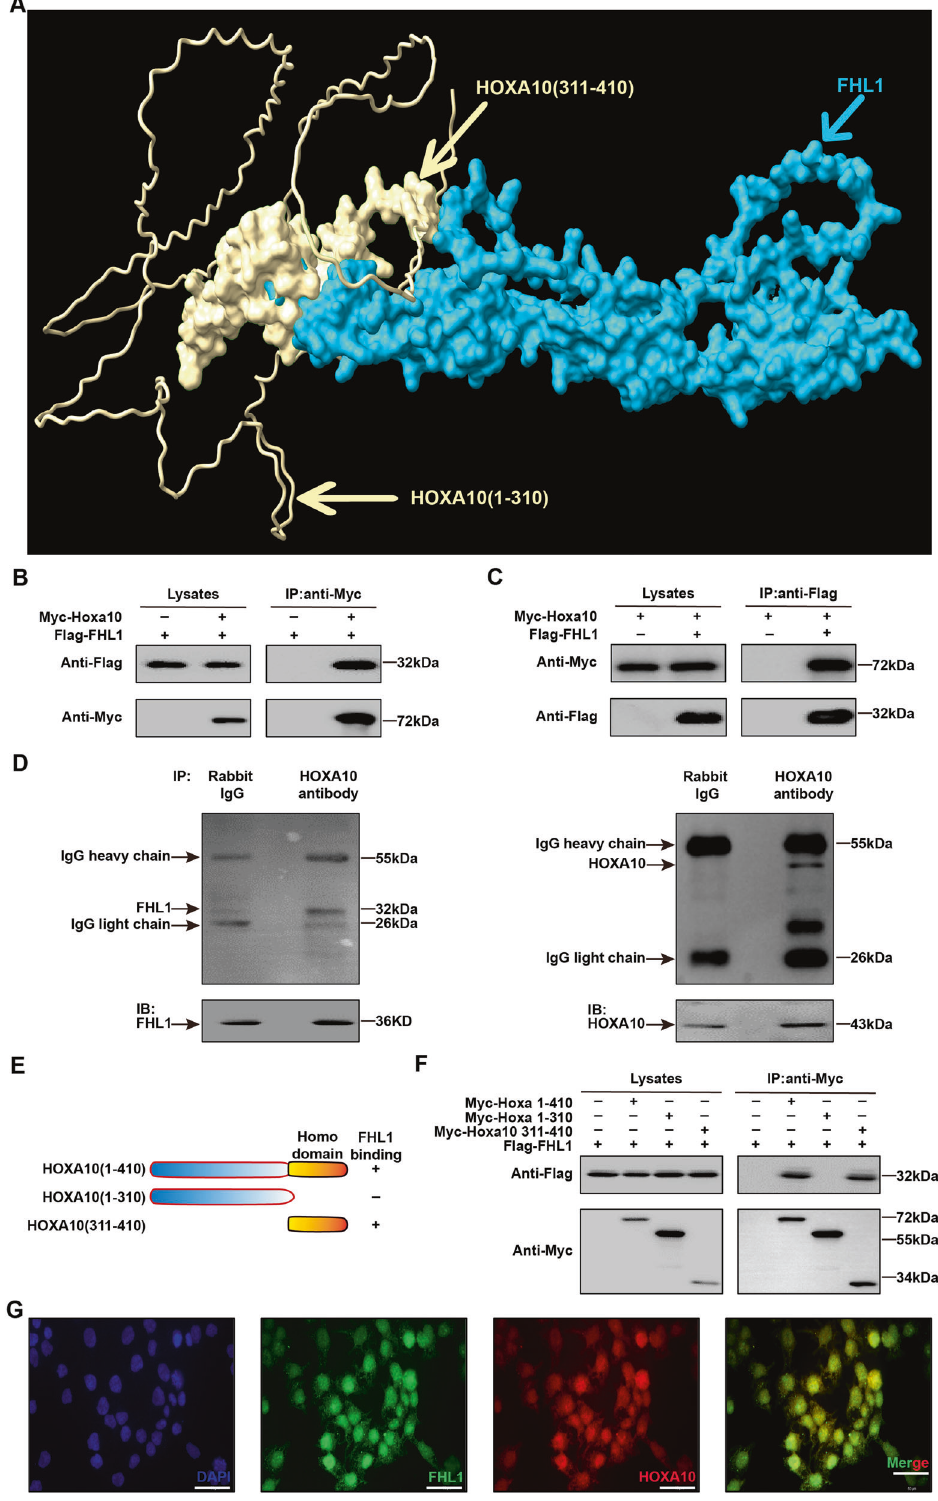
Fig. 4 FHL1 is a newly identi fi ed HOXA10-interacting molecule. A Bioinformatics-based prediction of structural interactions of FHL1 with HOXA10 protein. B , C Anti-Myc/Flag immunoprecipitation followed by immunoblotting analysis of whole-cell lysates of HEK293T cells transfected with Flag-FHL1 either alone or together with Myc-HOXA10. D Ishikawa whole-cell lysates were subjected to anti-HOXA10 immunoprecipitation followed by immunoblotting analysis. Goat IgG was used as a negative control. E Schematic diagram of the HOXA10 mutants in Fig. 4F. F Flag-FHL1 and different Myc-HOXA10 mutants were cotransfected in HEK293T cells, and whole-cell lysates were collected for anti-Flag immunoprecipitation and immunoblotting analysis. G Endogenous FHL1 and HOXA10 signi fi cantly colocalized in Ishikawa nuclei.